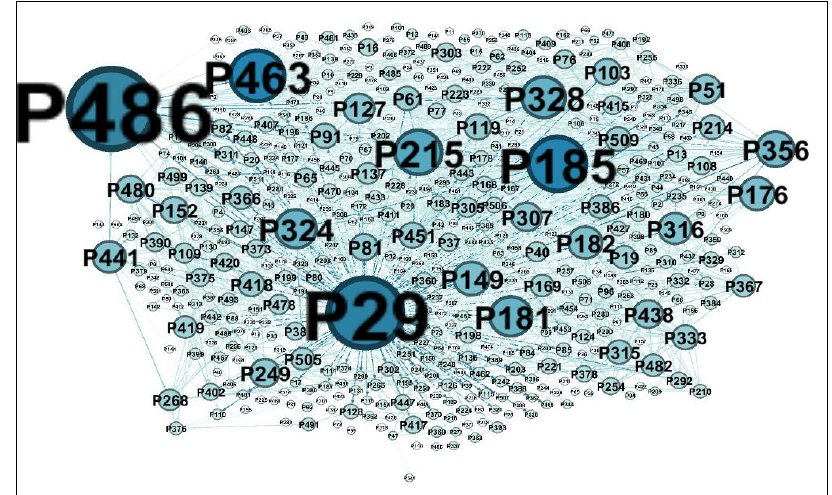
Figure 13. The CSE citation network.